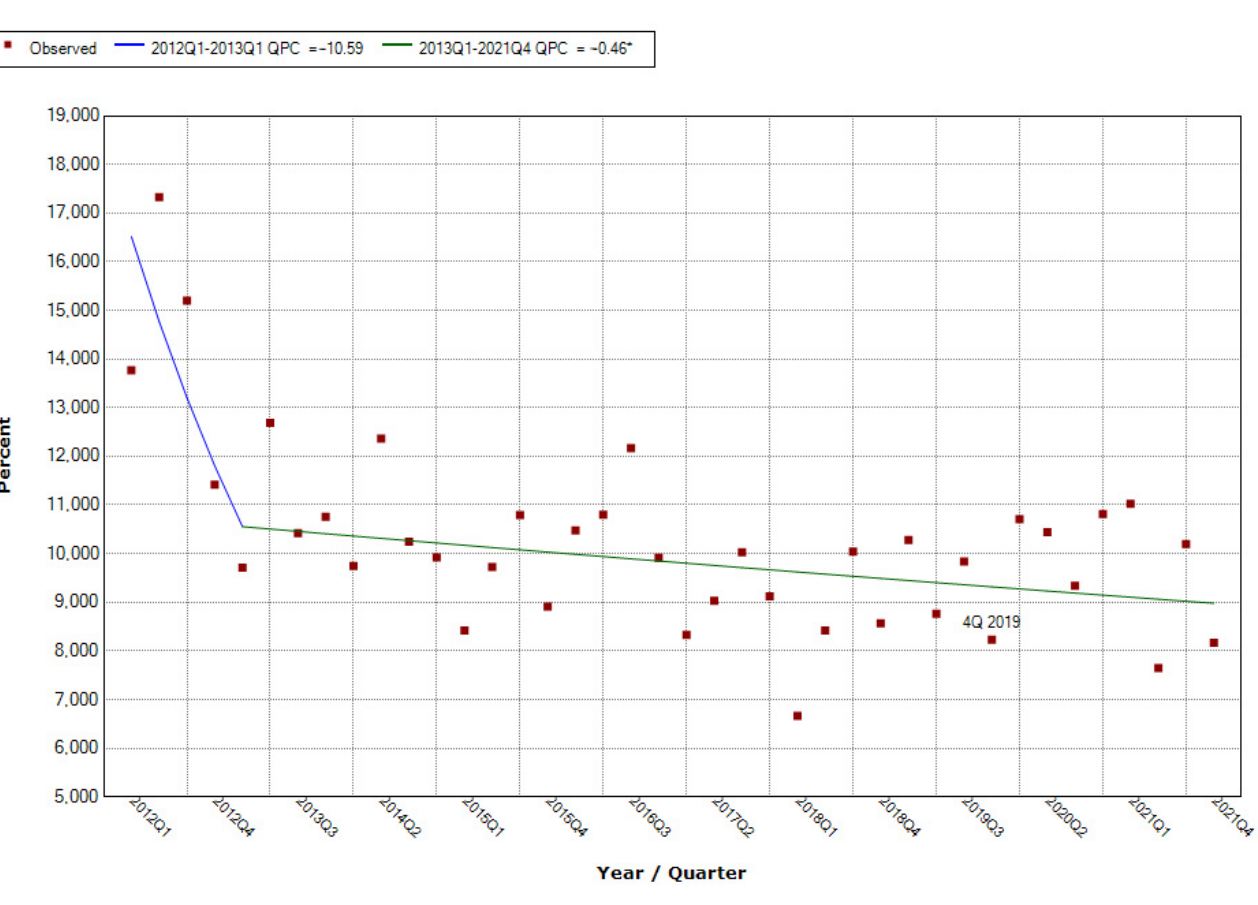
Figure A29. Percentage of products containing pantothenic acid in individual quarters in the period from 2012 to 28 November 2021. Joinpoints mark trend turning points. The date above the observation indicates the moment of publication of the scientific opinion/resolution.